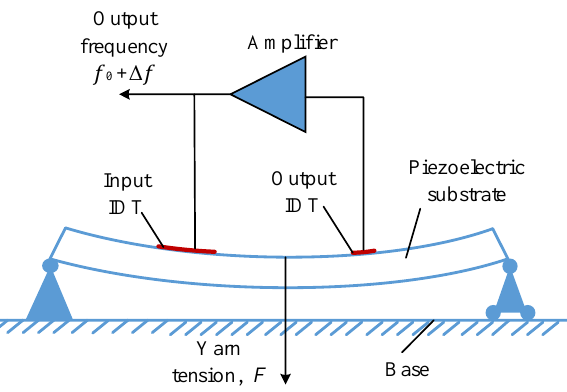
Figure 2. The working principle diagram of the SAW yarn tension sensor.